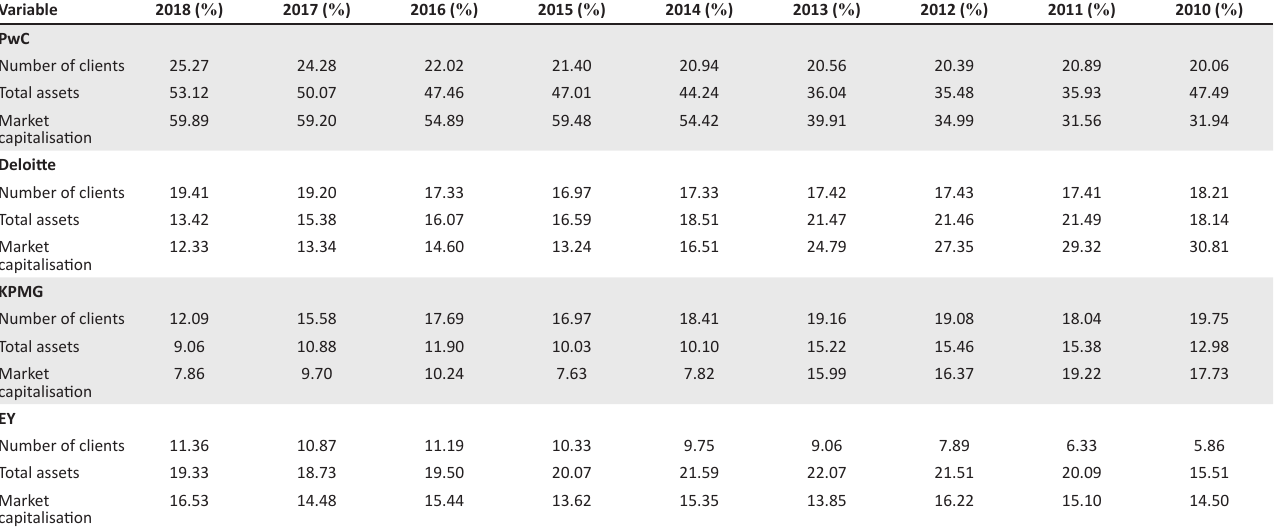
TABLE 4 : Market share per Big 4 audit firm in the South African audit market.